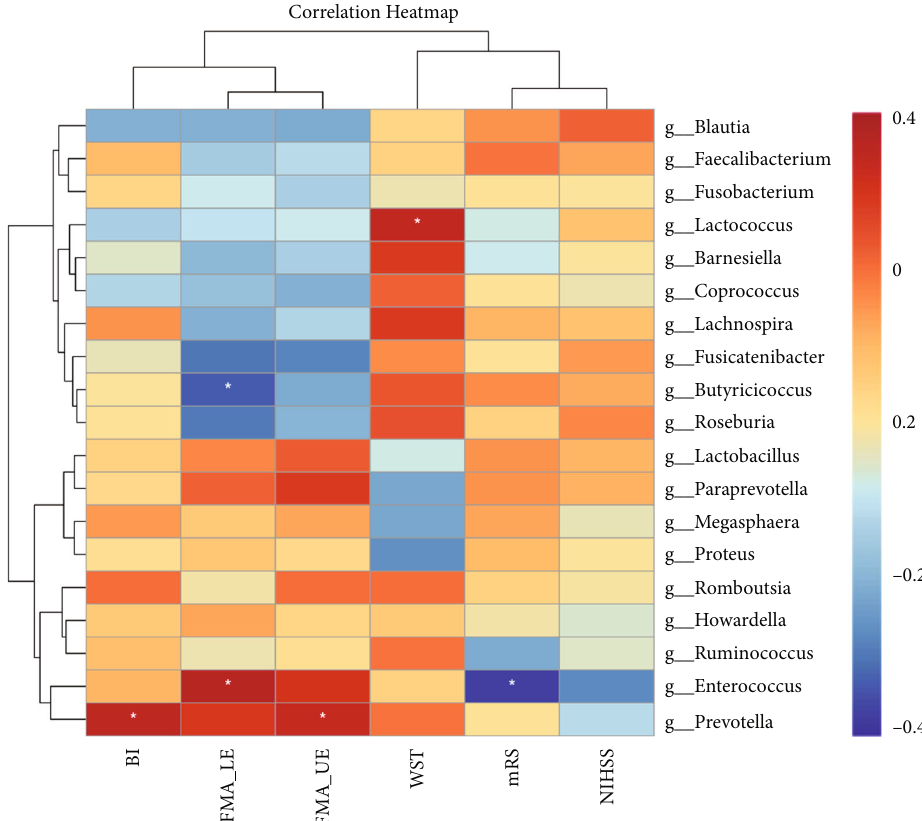
Figure 5: Correlations between di ff erentiated bacterial genus and variations of functional status. BI: Barthel index; FMA-LE: Fugl-Meyer assessment lower extremity scale; FMA-UE: Fugl-Meyer assessment upper extremity scale; WST: water swallow test; mRS: modi fi ed Rankin scale; NIHSS: National Institutes of Health Stroke Scale. ∗ p < 0 : 05